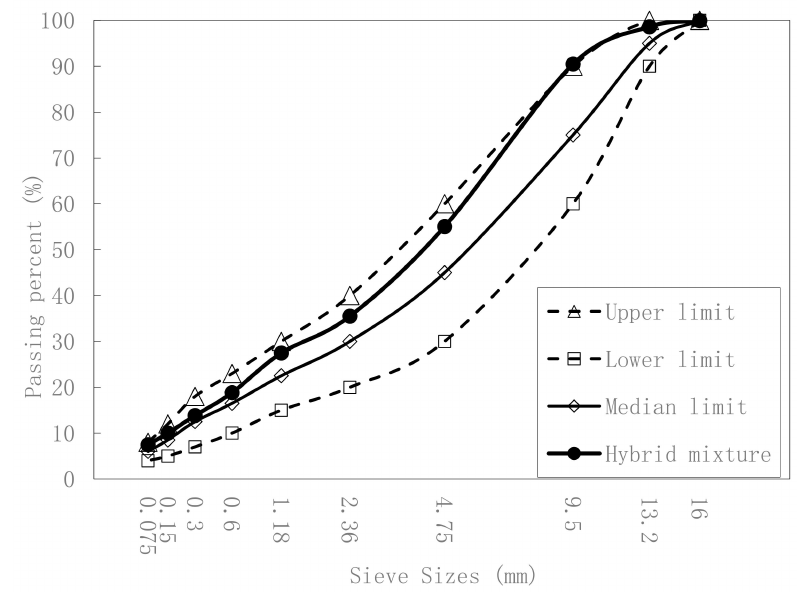
Figure 9. Gradation curve after heavy